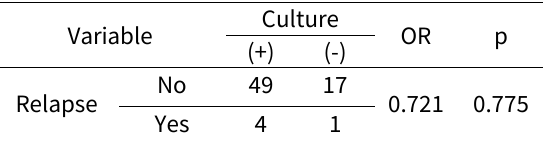
Table 4. Chi Square Analysis of the Incidence of Relapse based on Culture